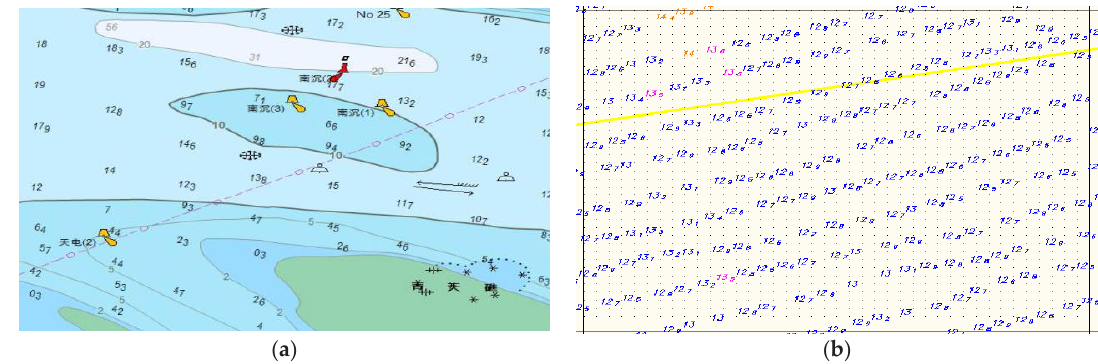
Figure 1. Waterway depth data (ground truth) from: ( a ) electronic chart display and information system (ECDIS) depth data; ( b ) berth map of depth.